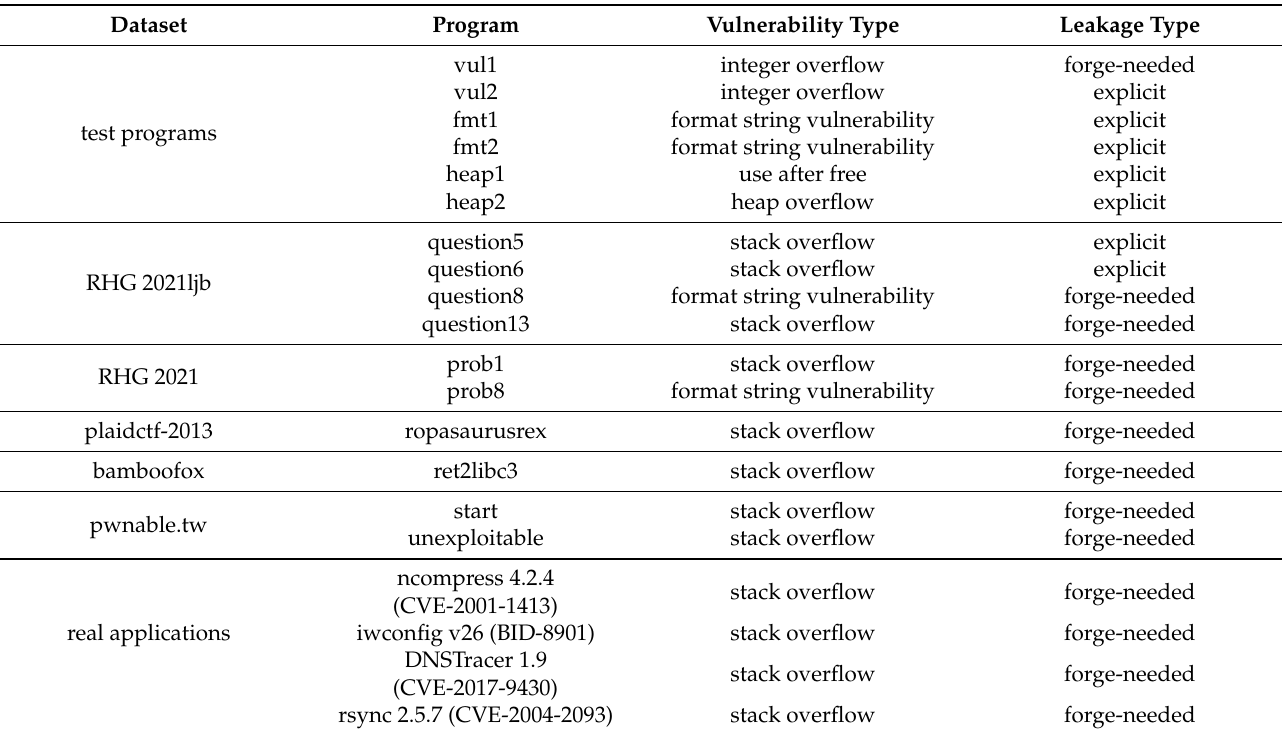
Table 2. Evaluation